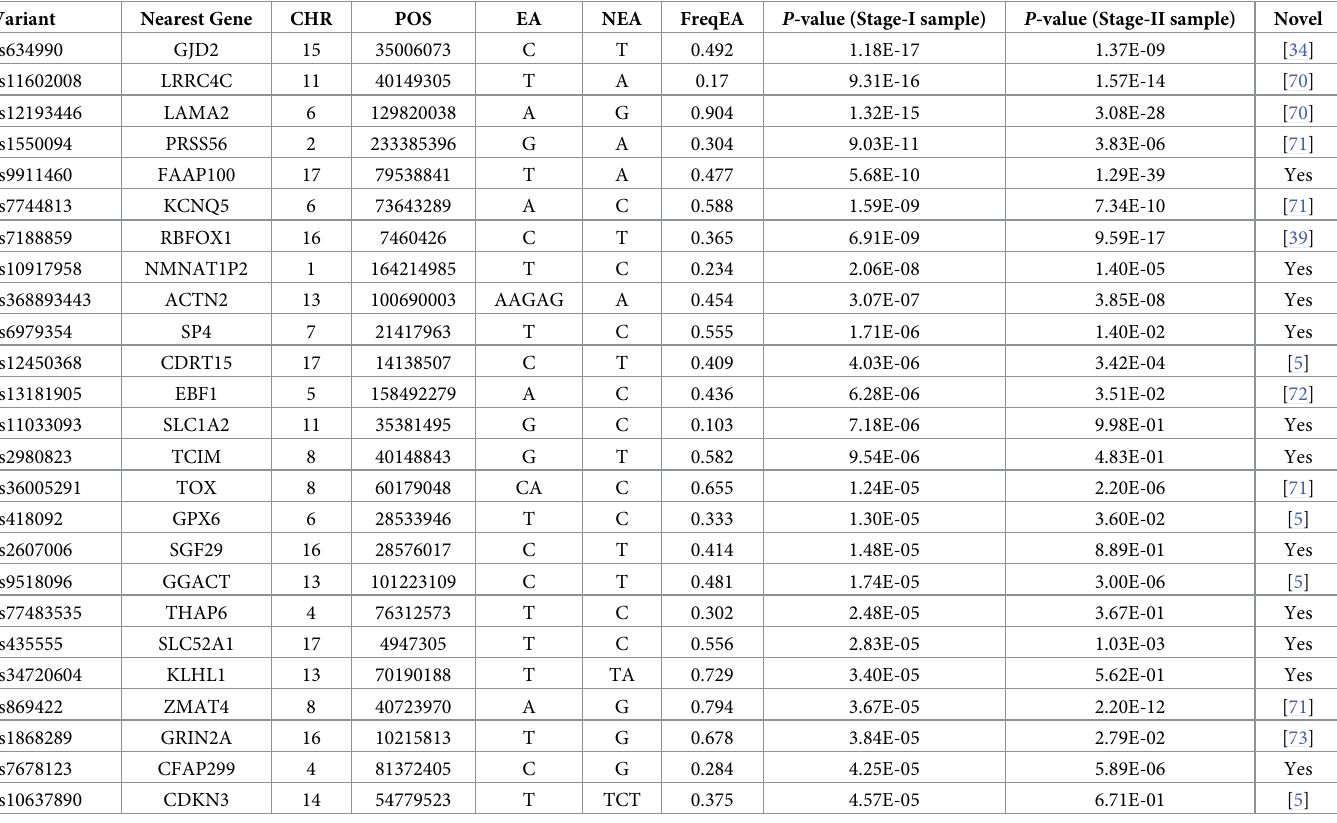
Table 2. Genetic variants significantly associated with variance in refractive error (variance heterogeneity). Levene’s median test p-values are given for the tests car- ried out in the Stage-I sample and the Stage-II sample. Variants are ranked by p-value in the Stage-I sample. Novel genes are indicated; a citation is given for genes previ- ously implicated in myopia development. The effect allele is the allele associated with a more myopic refractive error in a linear regression test for the marginal effect of the